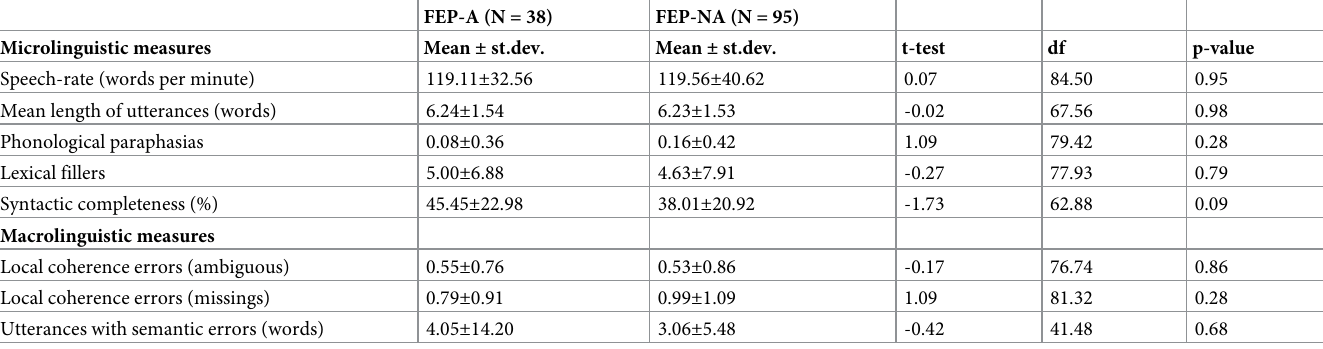
FEP, local coherence errors (both ambiguous and missing scores) negatively correlated with verbal IQ (p < 0.05). In the Group of HC, local coherence errors (ambiguous) correlate nega- tively with SOA12 sensitivity (p < 0.05). After correction (alpha level = 0.05 divided by the number of correlations), no correlations survived, neither in the group of FEP nor in the group of HC. Results are detailed as S3 Table.